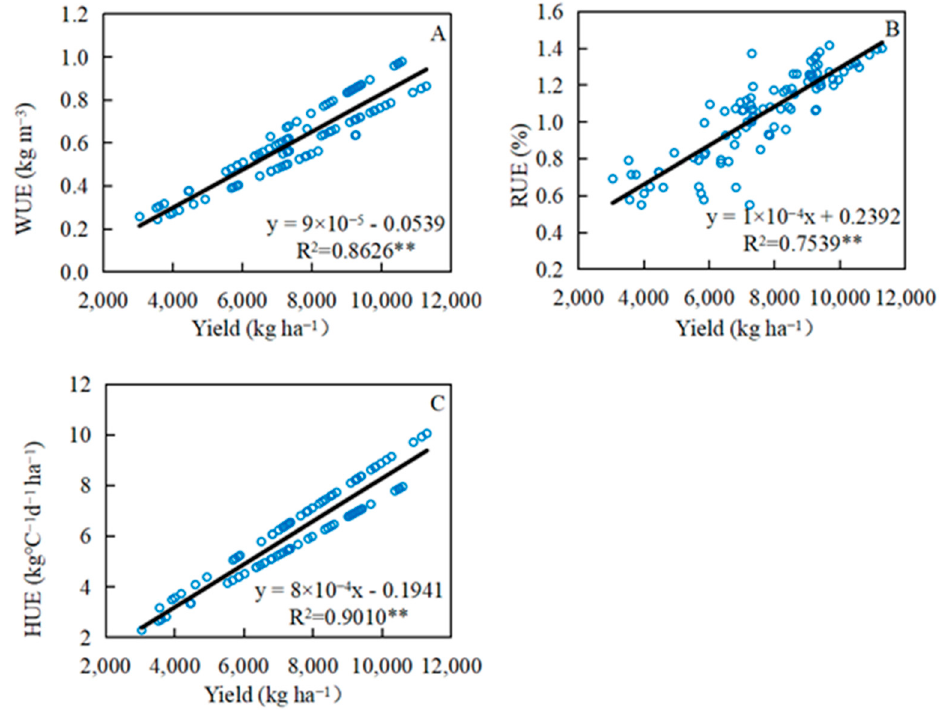
Figure 6. Correlations between yield and water-use efficiency (WUE) ( A ), radiation-use efficiency (RUE) ( B ), and heat-use efficiency (HUE) ( C ) throughout the growth period. **: Significant at 1% probability levels.